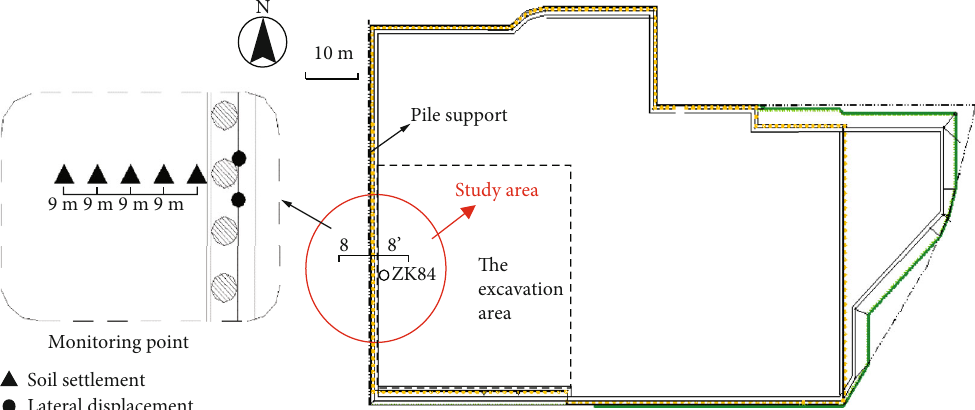
Figure 2: Plan layout of foundation pit support structure.